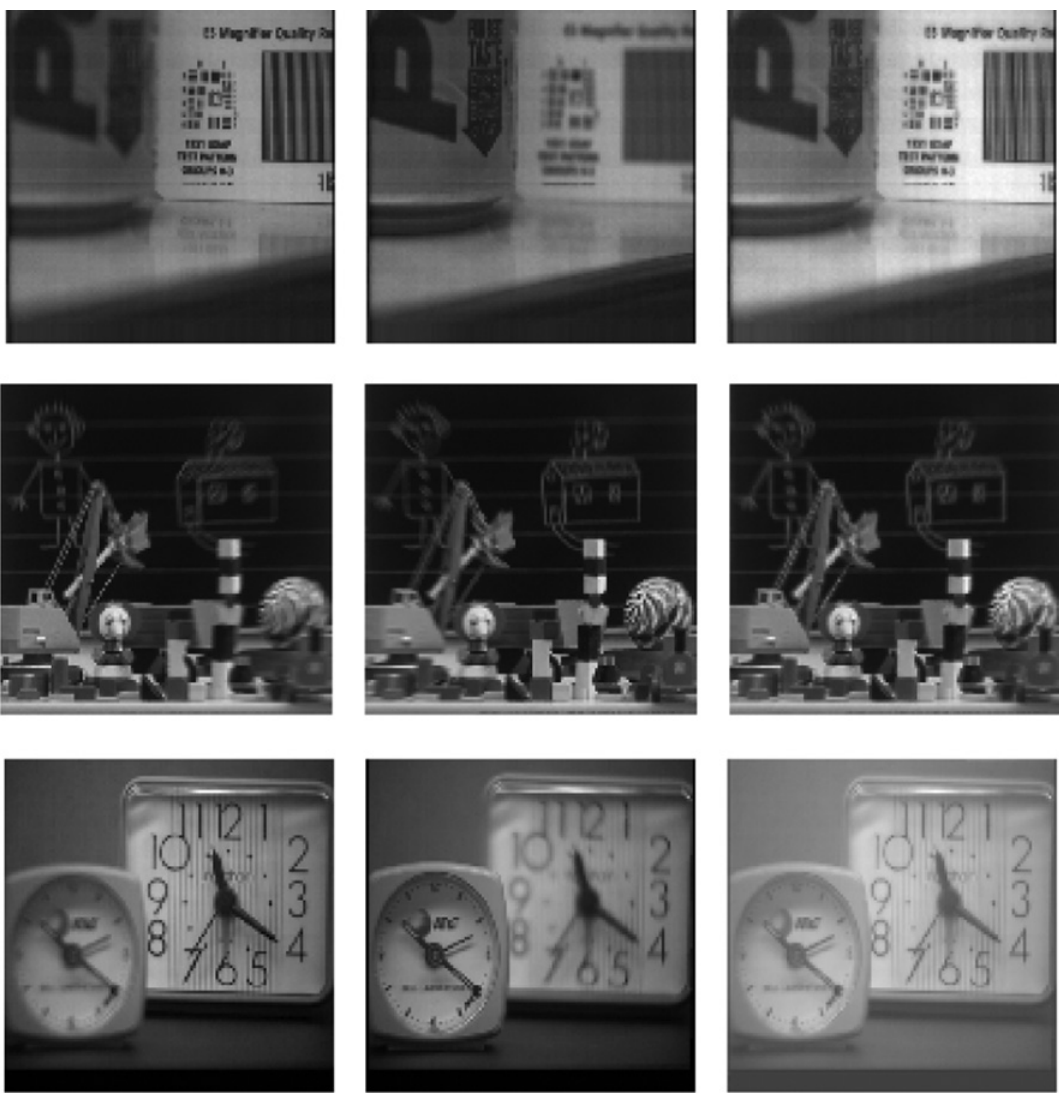
Figure 5: Fusion Results of Average and Absolute Maximum Fusion